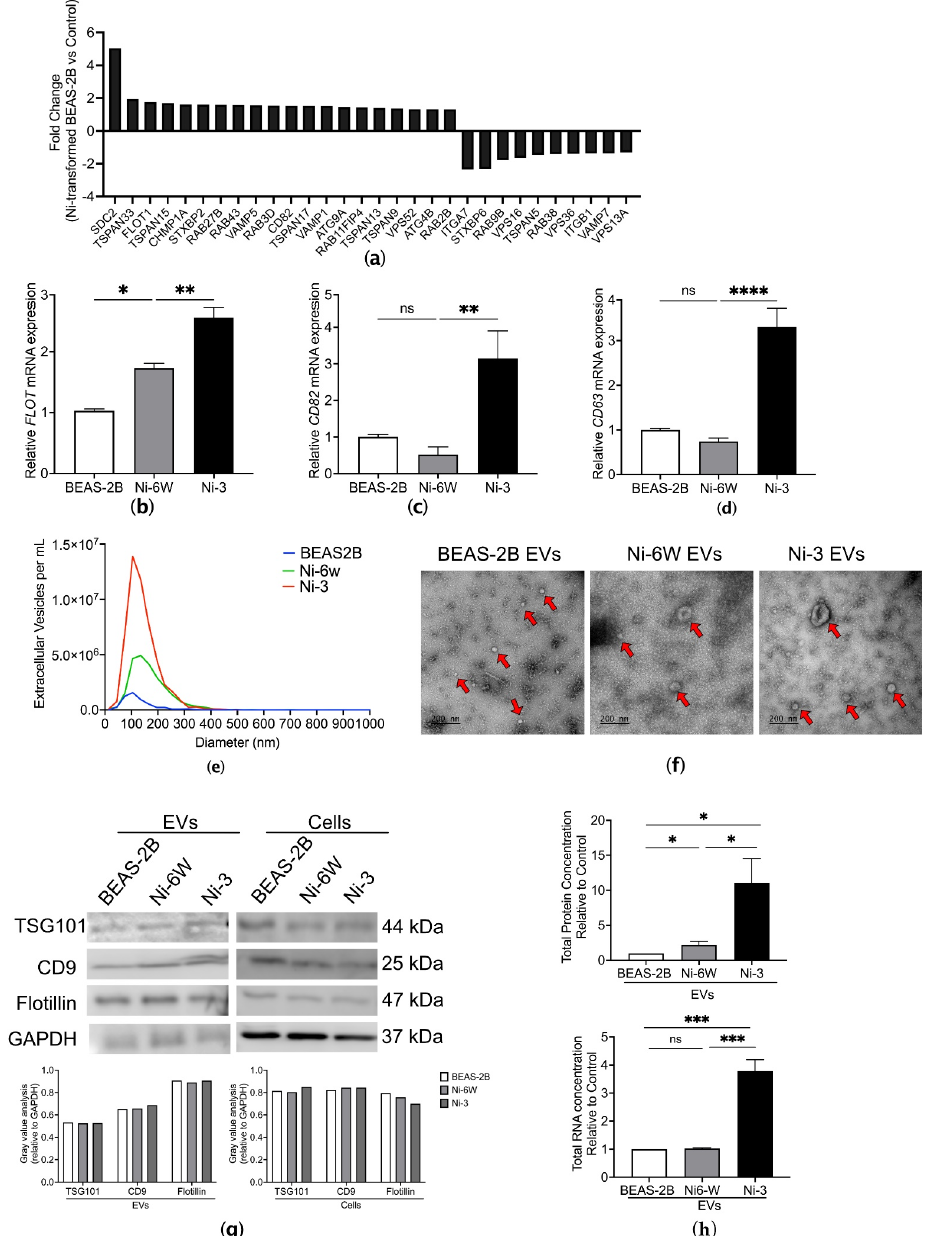
Figure 1. Characterization of EVs from Ni-treated and Ni-transformed BEAS-2B cells. ( a ) A total of 20 upregulated EV-related genes and 10 downregulated EV-related genes were identified in the Affymetrix gene expression arrays of Ni-transformed clones ( p < 0.05, FC > 1.3). ( b – d ) Comparison of mRNA expression of FLOT, CD82, and CD63 in BEAS-2B, Ni-6W, and Ni-3 cells. EVs from BEAS-2B, 6-week-Ni-treated BEAS-2B (Ni-6W), and Ni-transformed BEAS-2B (Ni-3) were subjected to serial ultracentrifugation (UC) and characterized by several methodologies including ( e ) nanoparticle tracking analysis (NTA), ( f ) transmission electronic microscopy (TEM), and ( g ) immunoblot of EV markers CD9, flotillin, and TSG 101. Red arrow: extracellular vesicles. ( h ) Comparison of total protein and total RNA of EVs between Ni-treated, Ni-transformed, and untreated BEAS-2B cells. Values are presented as mean ± SEM. ns: no significance, * p < 0.05, ** p < 0.01, *** p < 0.001, and **** p <